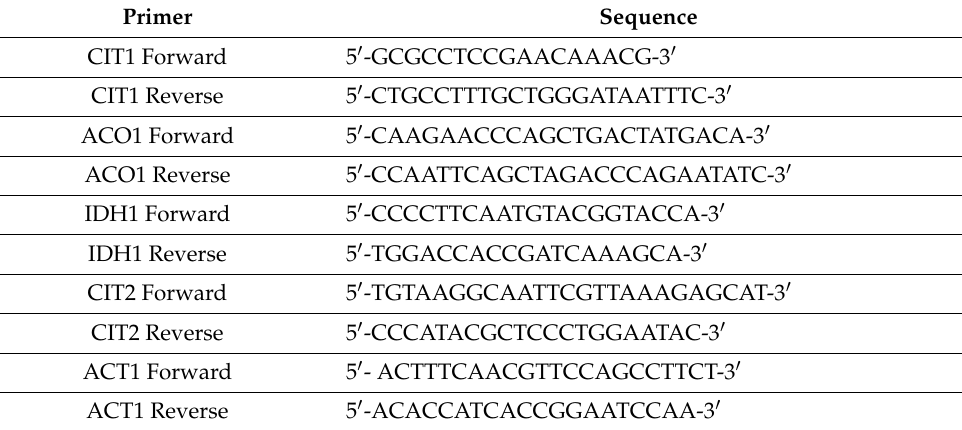
Table 2. Primers used for quantitative